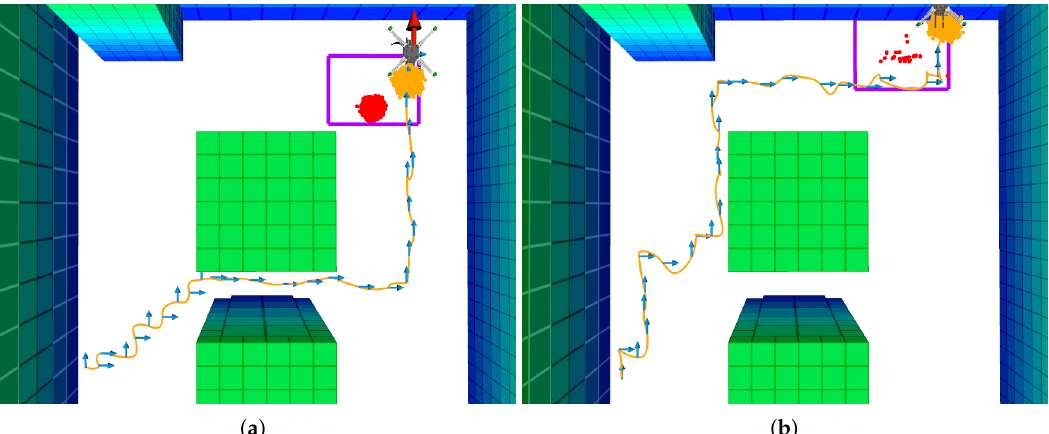
Figure 10. Flight mission examples of most frequent types of UAV trajectories under a single belief cluster. Orange splines represent the path of the UAV; the blue arrows are action commands per time step; green blocks are the environment obstacles; the orange point-cloud is the UAV position belief; the red point-cloud is the victim position belief; and the purple rectangle the camera’s Field of View (FOV). ( a ) UAV motion policy which crosses two of the column-shaped obstacles. ( b ) UAV motion policy which avoids crossing two of the column-shaped